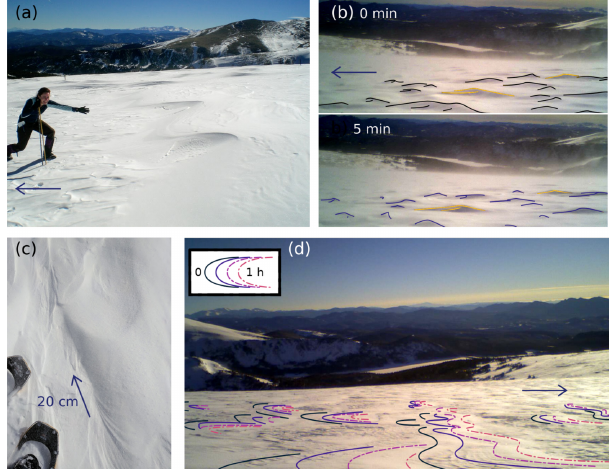
Figure 2. Snow dunes on Niwot Ridge, Colorado. (a) The 30– 40cm tall stationary barchan dunes on 3 March 2018. Temperatures are near freezing. The snow between the dunes, which has been marked by erosional bedforms, is now unmarked by the author’s weight. (b) Time lapse of close-packed dunes traveling downwind on 22 January 2018 from 13:29 to 13:34 (video S1 at 0:08). No hard or eroded snow is visible between the dunes. (c) The smallest barchan dune observed on Niwot Ridge, seen moving downwind at 11:25 on 9 November 2017 at 1–2cmmin − 1 . The < 1–5mm wide snow grains creep across the crest (video S1 at 0:57). (d) Time lapse of isolated barchan dunes from 07:20 to 08:20 on 17 January 2017 (video S1 at 0:39). Lines track the positions of the dune crests.